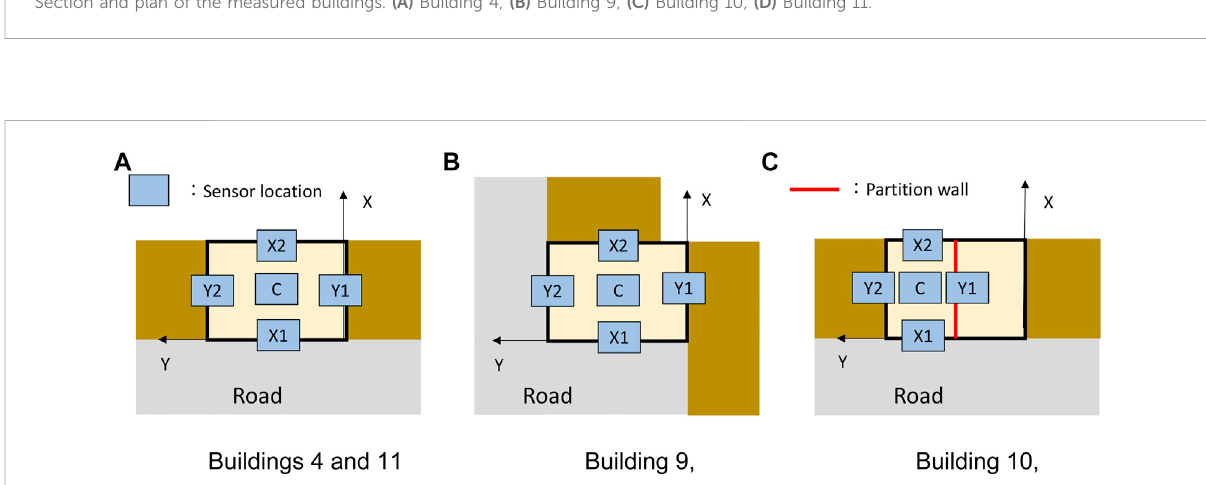
FIGURE 7 Sensor position notation at the measured building fl oor. (A) Buildings 4 and 11, (B) Building 9, (C) Building